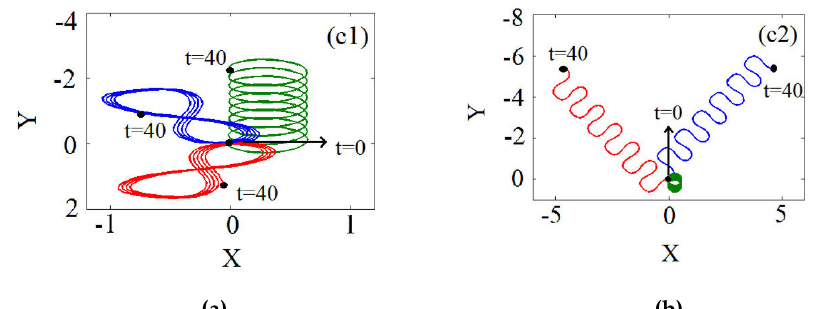
Figure 4. Motion of the c.m. of kicked asymmetric vortex solitons (AVS) with N = 0.15. ( a ) AVS with ( X ps , Y ps ) = ( 0.12,0 ) . The kick k = ( k x , k y ) = (+ 0.5,0 ) (blue curve), ( − 0.5,0 ) (red curve) and ( 0, + 0.5 ) (green curve). ( b ) ( X ps , Y ps ) = ( 0.26,0 ) with the same kick [58].